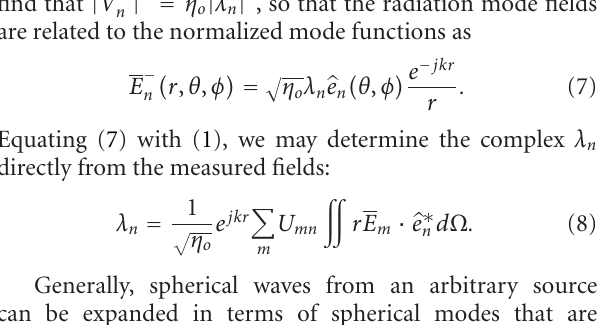
Figure 1: Radiated fields are represented by radial waveguides, one per mode, whose amplitudes are given by the traveling wave voltages and currents. Orthogonality of the modal fields ensures that power flows independently along the radial